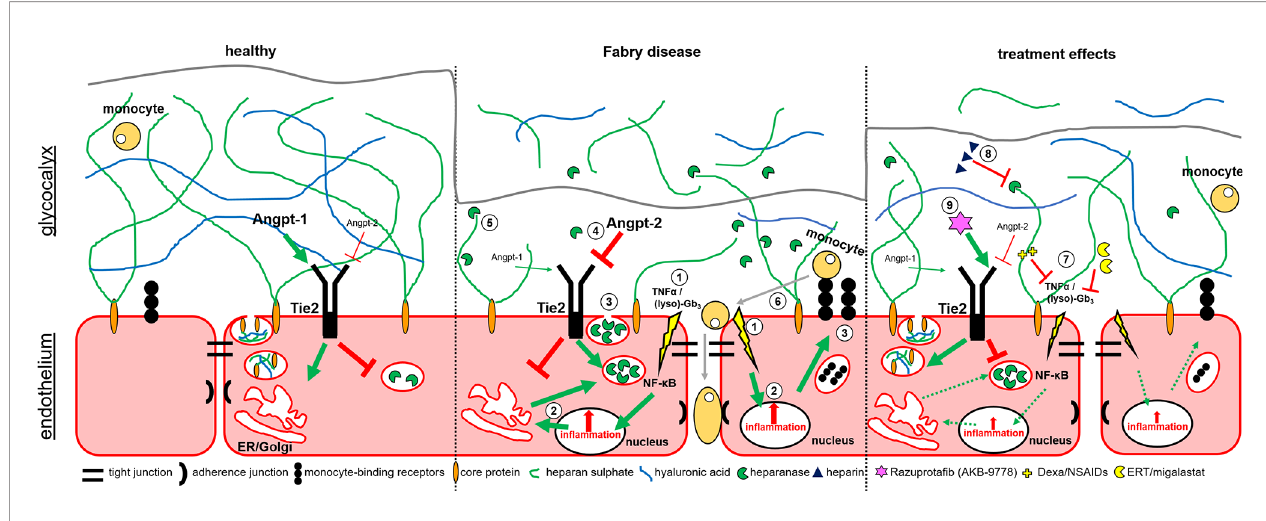
FIGURE 5 | Potential mechanisms involved in glycocalyx damage and endothelial dysfunction in Fabry disease. Schematic overview of the endothelial cell layer in healthy (left), Fabry disease (middle) and treated Fabry disease (right). 1. Lyso-Gb 3 and pro-in fl ammatory cytokines (TNF a ) mediate NF- k B-mediated in fl ammatory signaling and gene expression. 2. In fl ammatory response leads to an increased expression of heparanases and pro-in fl ammatory proteins such as monocyte-binding receptors. 3. Release of heparanases and presentation of monocyte-binding factors. 4. In addition, high Angpt-2 expression leads to a binding of Vascular Endothelial Protein Tyrosine Phosphatase (VE-PTP) to Tie2 and thus a direct release of heparanases. 5. Heparanases degrade the glycocalyx, leading to a release of free GAGs and hyaluronic acid (HA). 6. Damaged glycocalyx and increased expression of monocyte-binding receptors lead to an increased binding of monocytes to cell adhesion molecules with subsequent endothelial invasion. In fl ammatory stimulus increases the expression of cell adhesion molecules on the cell surface. 7. FD-speci fi c therapy (ERT, migalastat) or anti-in fl ammatory drugs (NSAIDs, dexamethasone) decrease the (lyso)-Gb 3 - and/or TNF a -mediated in fl ammatory stimuli. 8. Heparin inhibits heparanases, preventing glycocalyx degeneration. 9. Razuprota fi b (AKB-9778) inhibits the binding of VE-PTP to TIE2 preventing subsequent heparanase